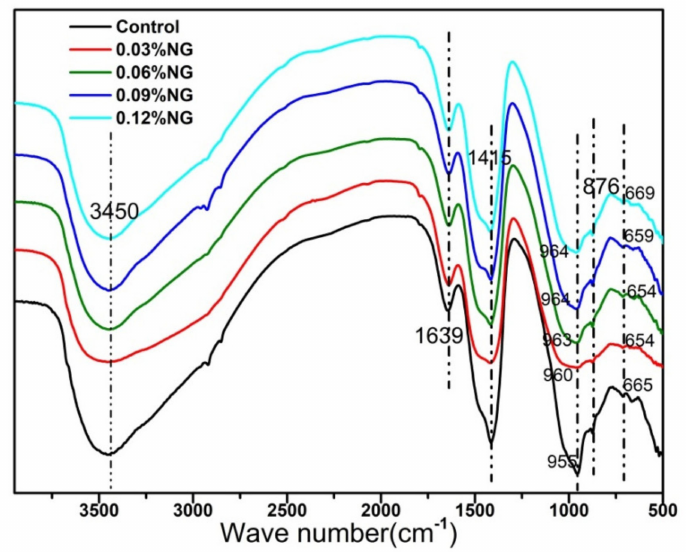
Figure 9. FTIR spectrogram of